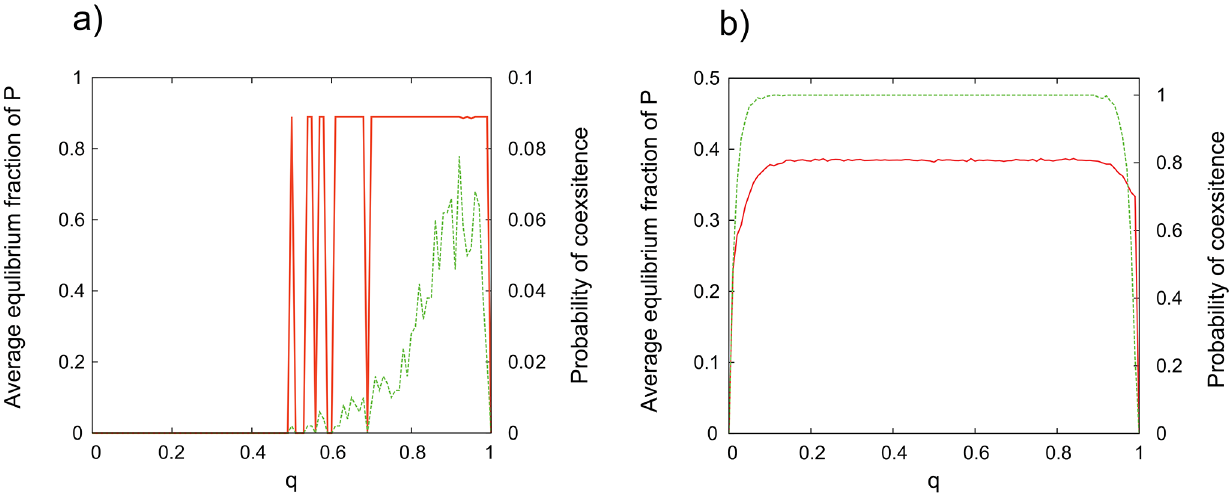
Figure 5. Average fraction of P cells (red, solid line) and the estimated probability of coexistence in function of the initial ratio of P - s (green, dashed line) if P cells are randomly placed initially. Red lines denote the average fraction of P , green lines denote the probability of coexistence. a ) Linear model, DpB update. l ~ 10 , d ~ 1 : 2 . (The model with pDB update rule behaves practically identically at these parameters.) b ) Nonlinear model, DpB update. l ~ 10 , d ~ 0 : 01 , c 0 ~ 0 : 5 e { 1 = l . Plotted values are averages of 500 independent simulations, N ~ 100 , a ~ 1 in all